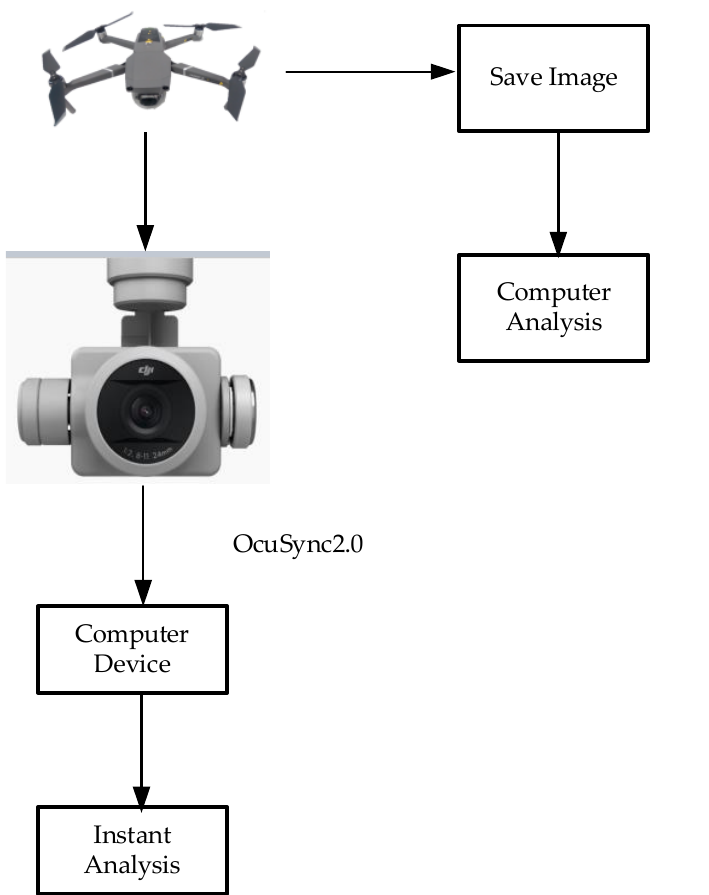
Figure 8. A functional diagram of the system hardware.